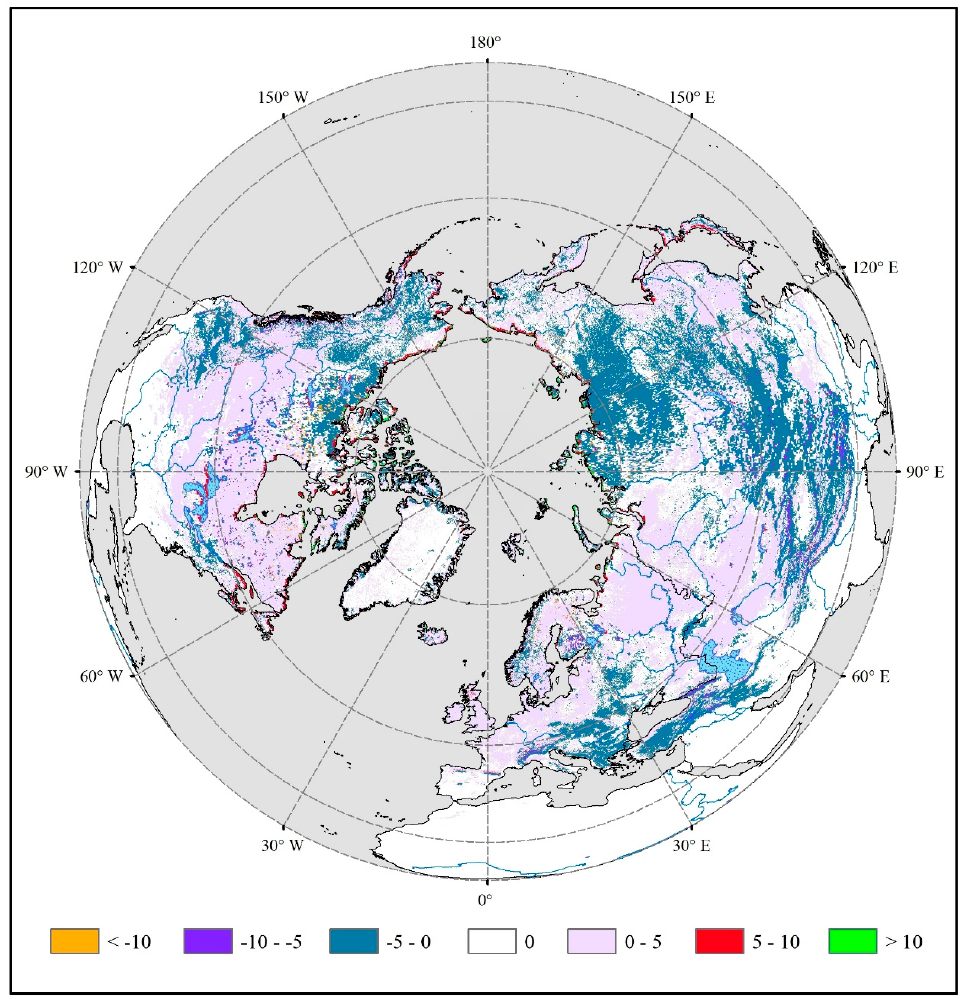
Figure 10. Variation slope of the average annual SCDs in the Northern Hemisphere based on Sen’s median method from 2000 to